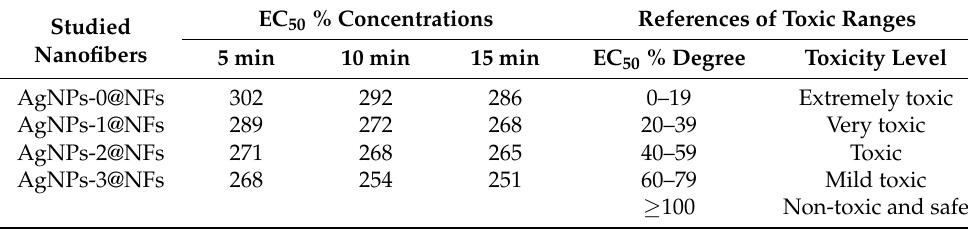
Table 4. Concentrations Microtox ® EC 50% of the 500 mg/L as MICs of AgNPs-3@NFs .